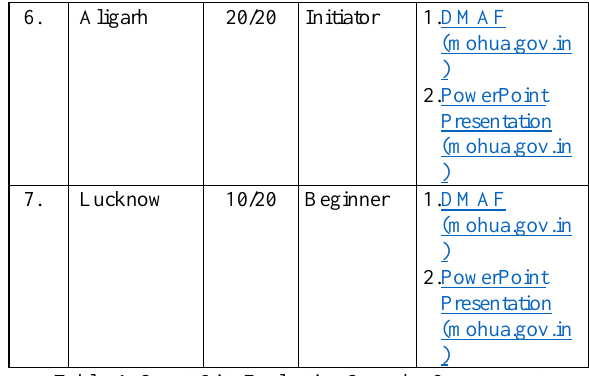
Table_1: Smart City Evaluation Score by Government 7.0 THE WAY